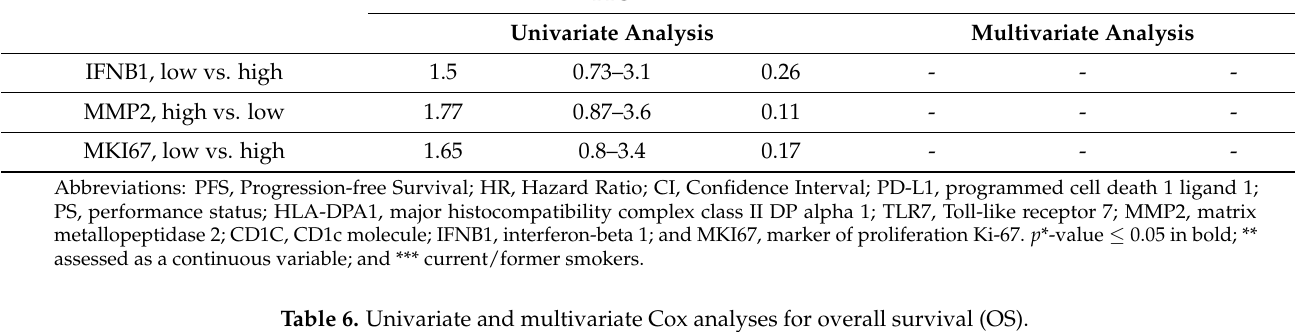
Table 6. Univariate and multivariate Cox analyses for overall survival (OS). OS Univariate Analysis Multivariate